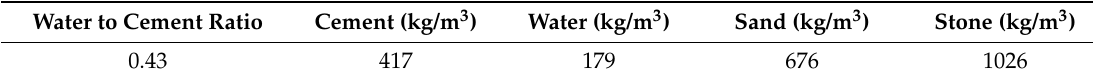
Table 5. Twenty-eight-day compressive strength of concrete [32].